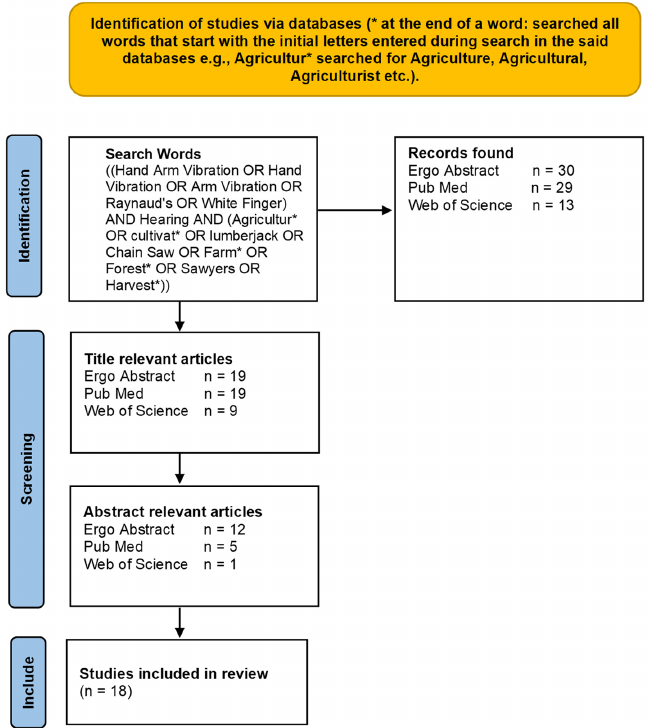
Figure 1. Flow diagram of article search results.